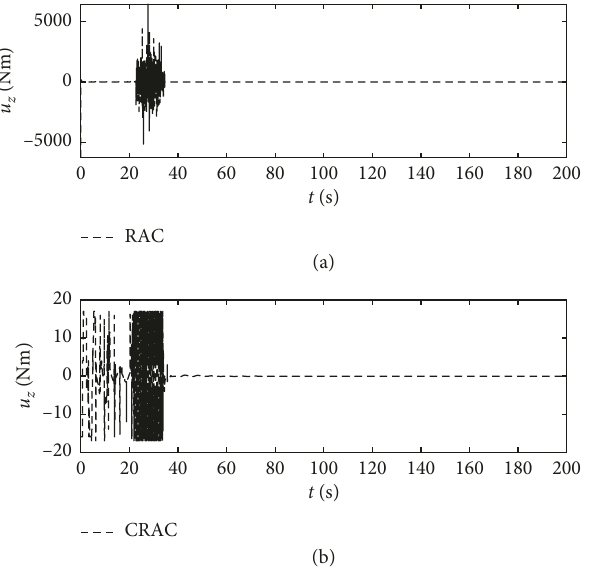
Figure 19: Time response of output control torque τ z